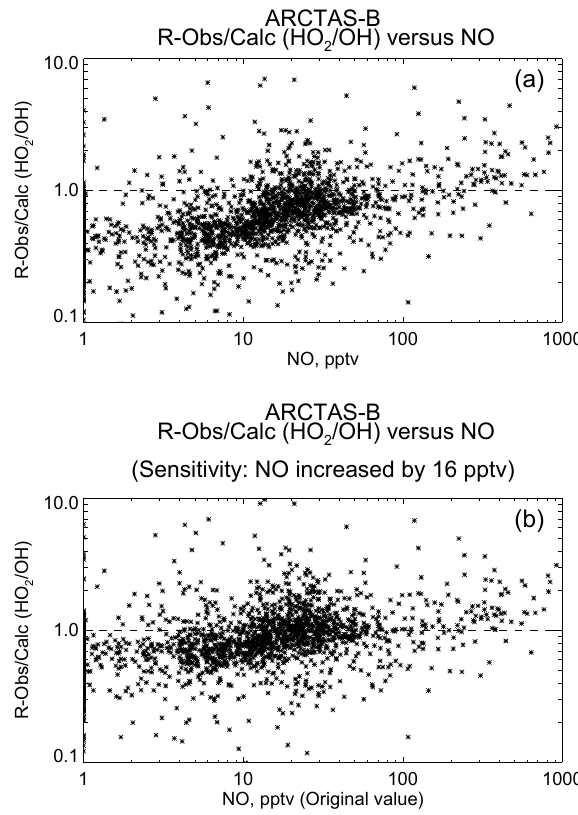
Fig. 12. Observed-to-calculated ratio of the HO 2 /OH partitioning during ARCTAS-B as a function of NO. Results from the standard model simulation are shown in (a) and results when NO is univer- sally increased by 16pptv are shown in (b)